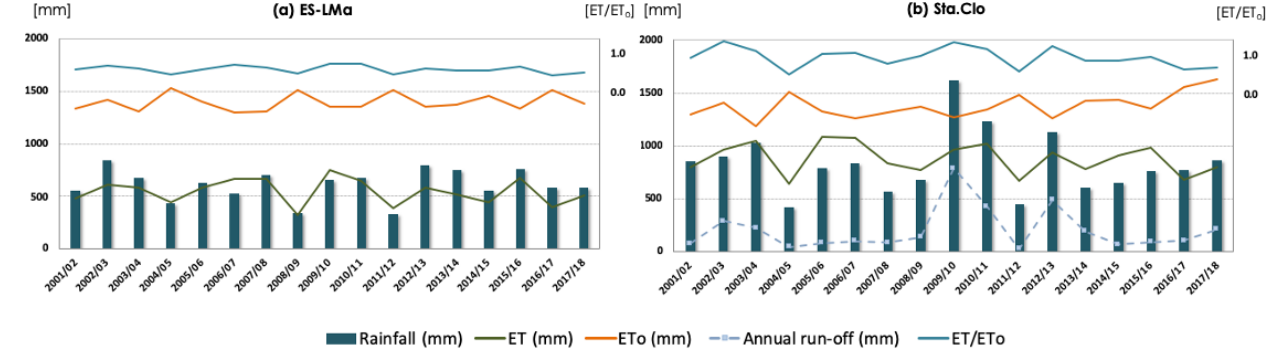
Figure 3. Evolution of annual rainfall, ET, ET o and ET / ET o at the ES-LMa site (a) and the Sta.Clo site (b) and annual runoff at Sta.Clo watershed from the hydrological years 2001/2002 to 2017/2018.